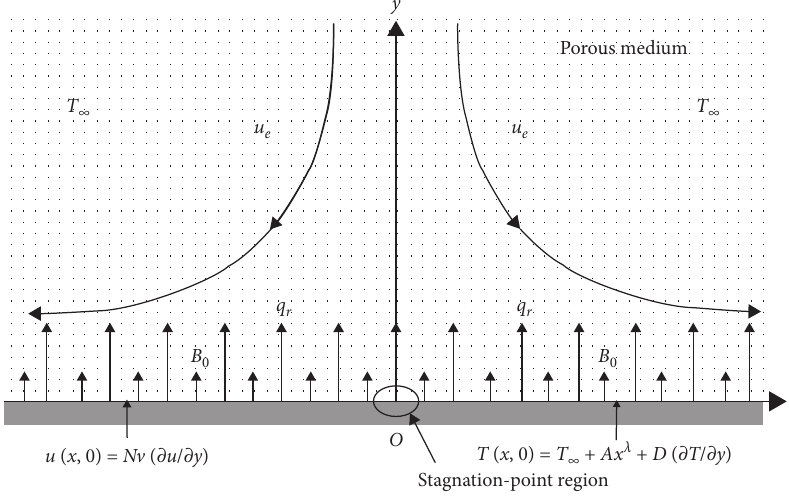
Figure 1: Geometry of the flow